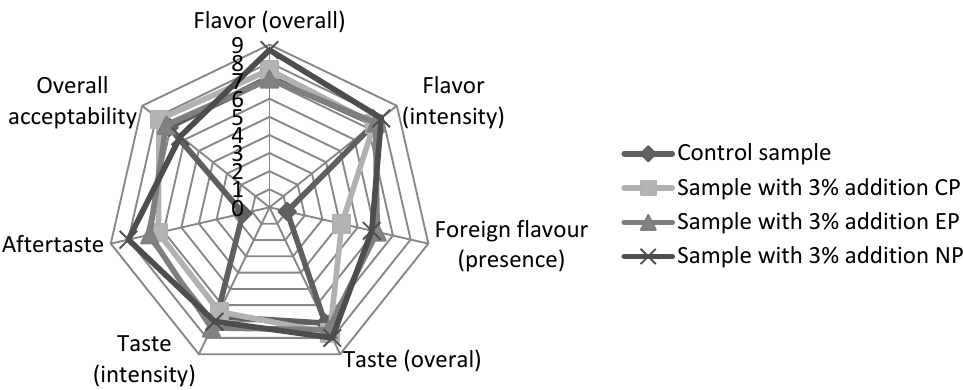
Table 5. Mass, gross calorific value, and standard error.